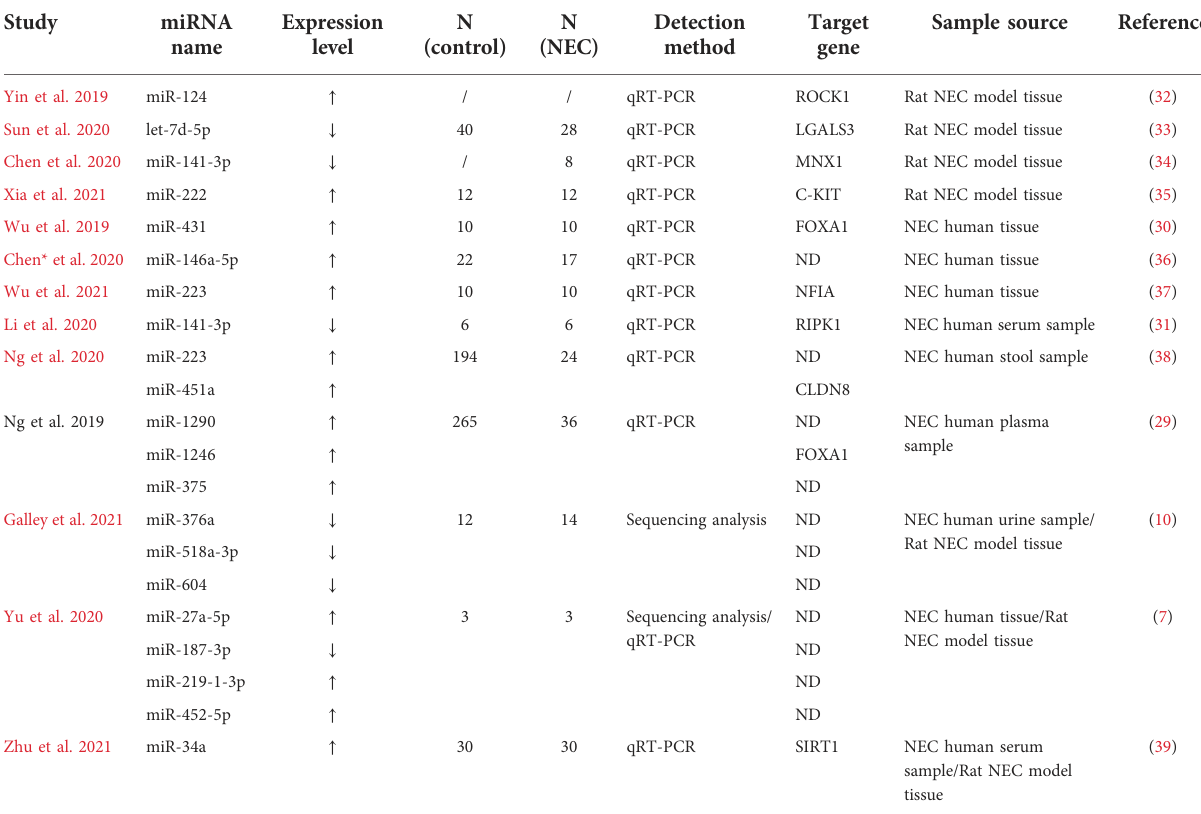
TABLE 1 A summary of miRNAs ’ expression levels of NEC in different studies.